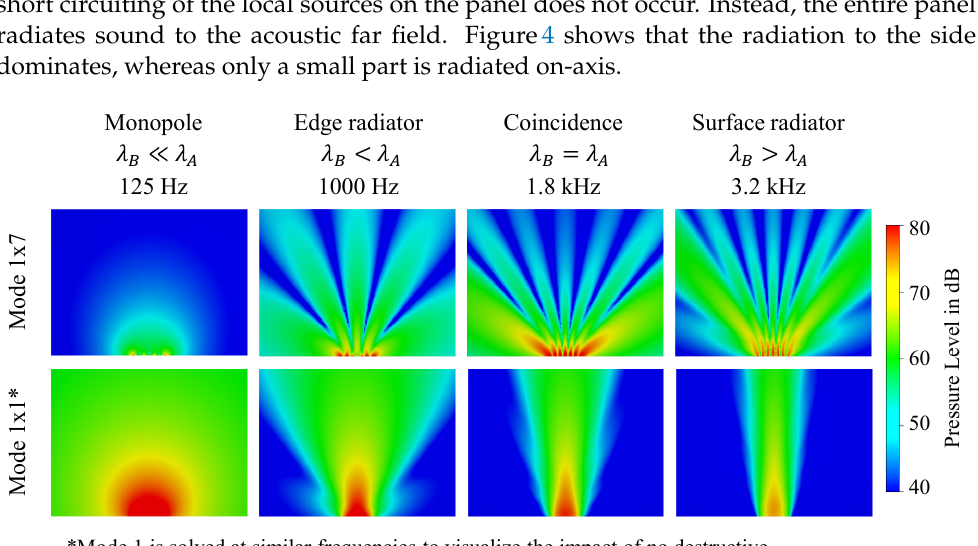
Figure 4. Radiation of the mode1 × 1 and mode 1 × 7 to visualize the frequency-dependent impact of several sound sources of a complex mode and the different radiation mechanisms for mode1 × 7 depending on the acoustic wavelength λ A